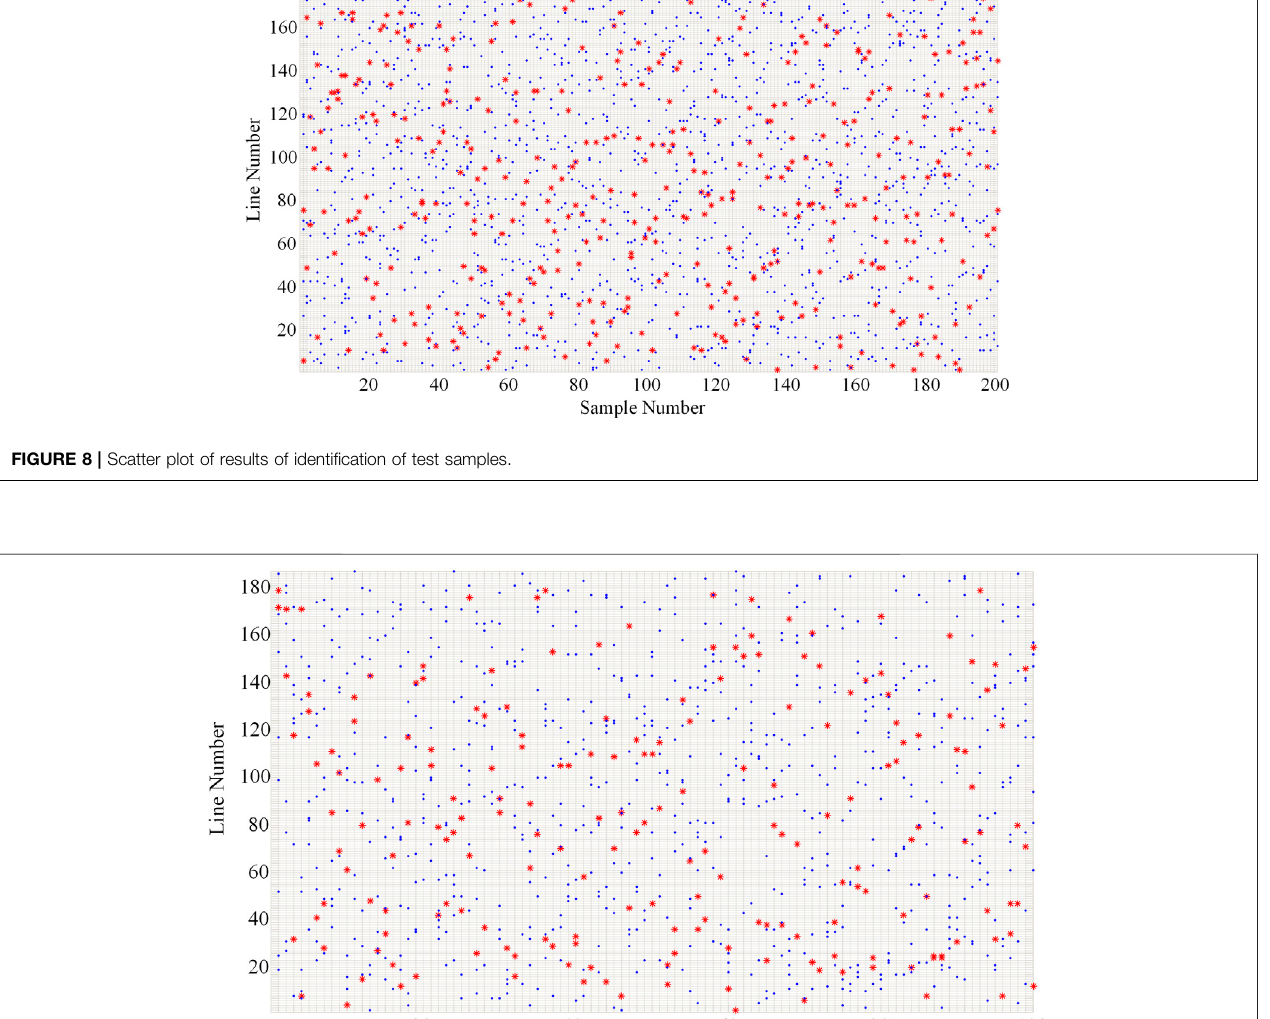
Frontiers in Energy Research |